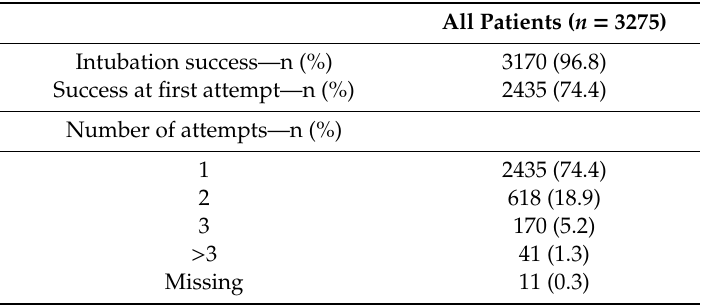
Table 2. Primary and secondary outcomes 1